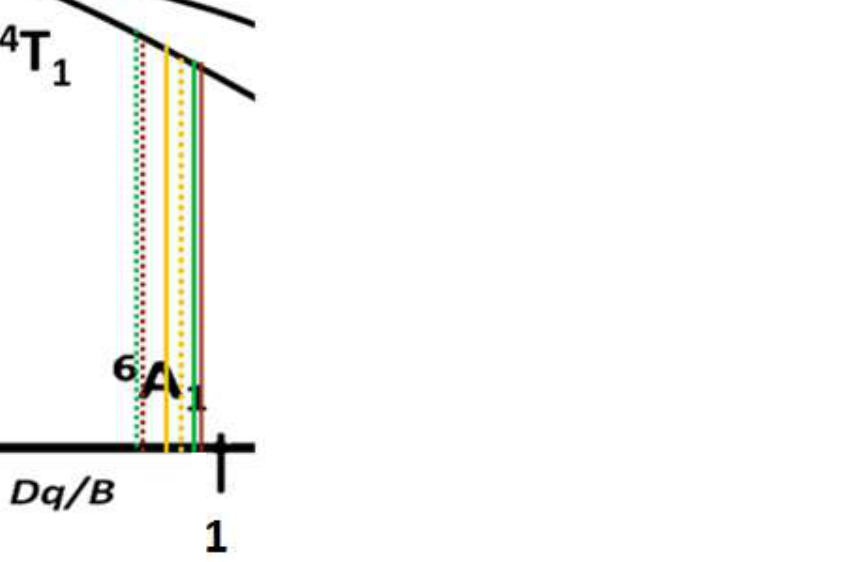
Figure 13. Part of the Tanabe–Sugano diagram; genthelvite G1—yellow lines, willemite W1—maroon line, willemite W2—green lines; solid lines continuous lines for Dq / B cases calculated from Formula (1), dashed line according to the text: yellow line for covalent bond participation, Formulas (4) and (5) from Table 8, green line—for Dq 2 in Table 9, wine line—for Dq 2 in Table 10. 3.5. Calculations of Dq, Racah B and C Parameters, the Energy of Excited Levels, and Split the